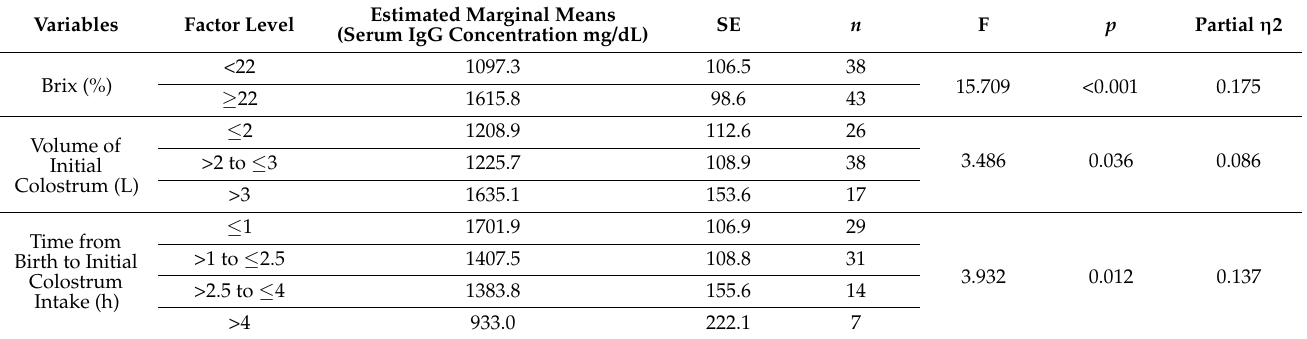
Table 1. Variables associated with serum IgG concentration at 1–4 day of Holstein calves on eight commercial dairy farms ( n =